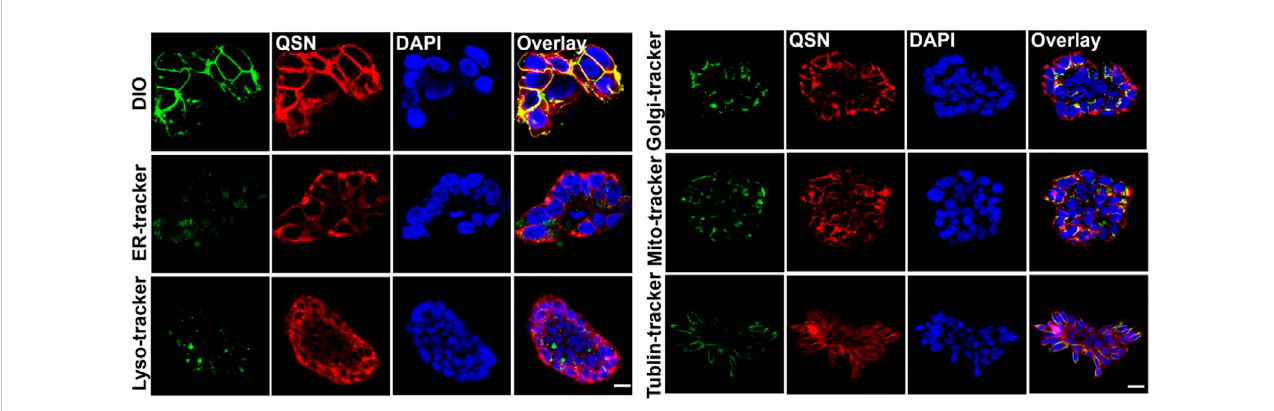
FIGURE 2 Confocal imaging of human embryonic stem cells-7 (H7) co-stained with QSN (50 μ M), DiO, ER-Tracker, lysosome tracker, Golgi-Tracker, MitoTracker, andTublinTracker.CellswereincubatedwithQSNfor15 min,anddifferentorganelle trackerswereaddedandincubatedforanadditional30 minto1 h.DIO, ER-Tracker, and MitoTracker were incubated with cells for 30 min. Lysosome tracker, Golgi-Tracker, and Tublin Tracker were incubated with cells for 1 h according to the protocols. Scale bar: 20 µm. All experiments were carried out three times independently.